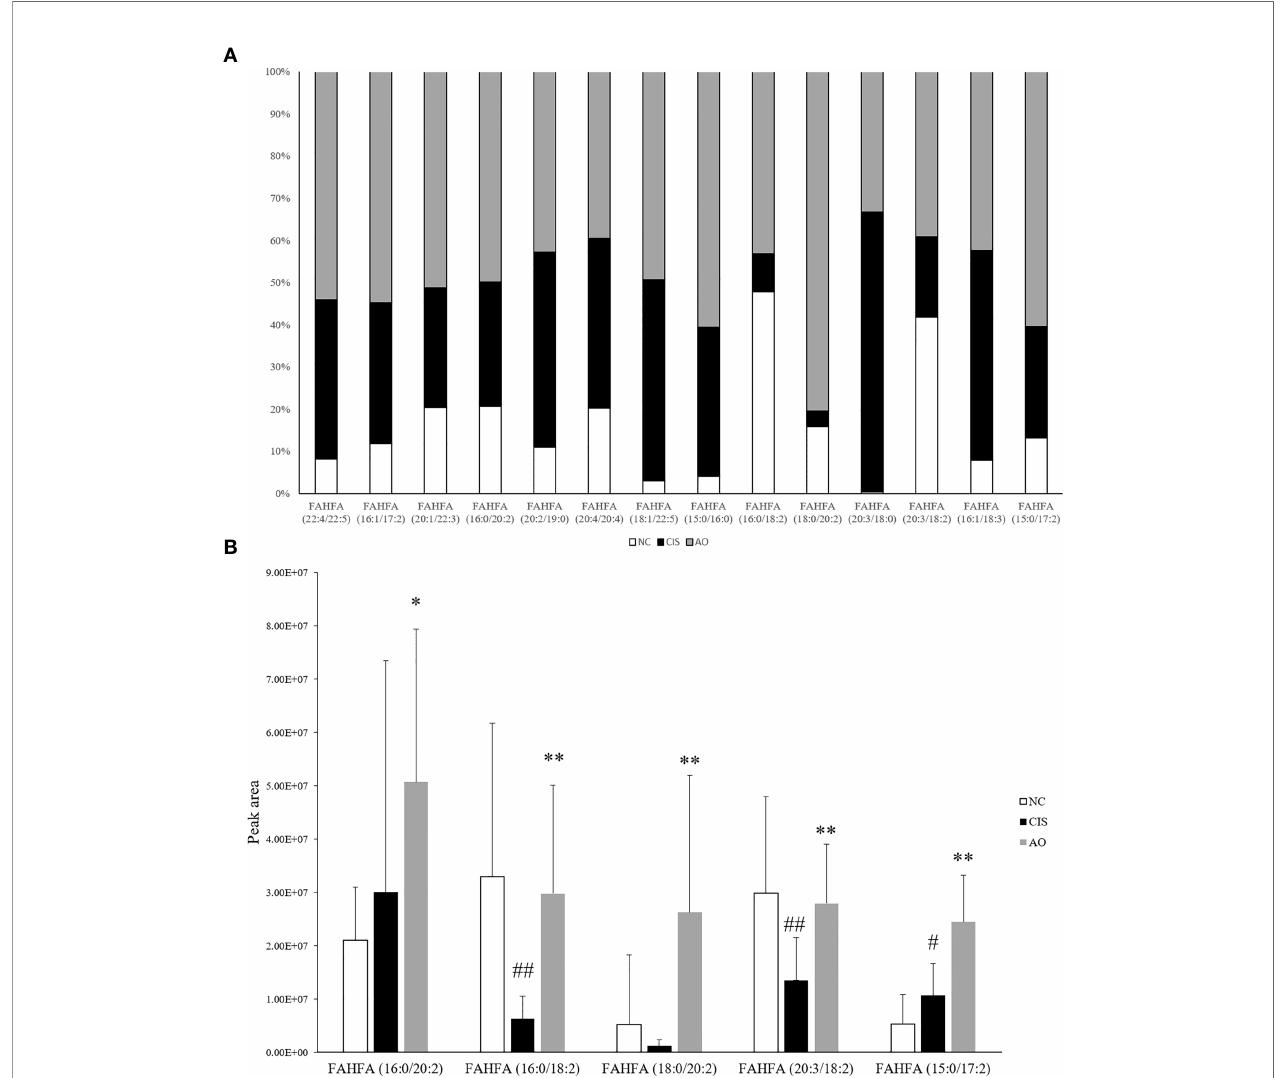
FIGURE 5 | FAHFAs levels in feces. (A) Comparison diagram of relative content of all we matched FAHFAs; only FAHFA (20:2/19:0), FAHFA (20:4/20:4), FAHFA (20:3/18:0) and FAHFA (16:1/18:3) were decreased in AO vs. CIS. but those FAHFAs were no signi fi cant difference between AO and CIS groups (p>0.05). (B) Relative content bar graph showing signi fi cant differences in AO vs. CIS FAHFAs; the signi fi cance marker on AO indicates AO vs. CIS (* p< 0.05, ** p< 0.01), the signi fi cance marker on CIS indicates CIS vs. NC ( # p< 0.05, ## p<